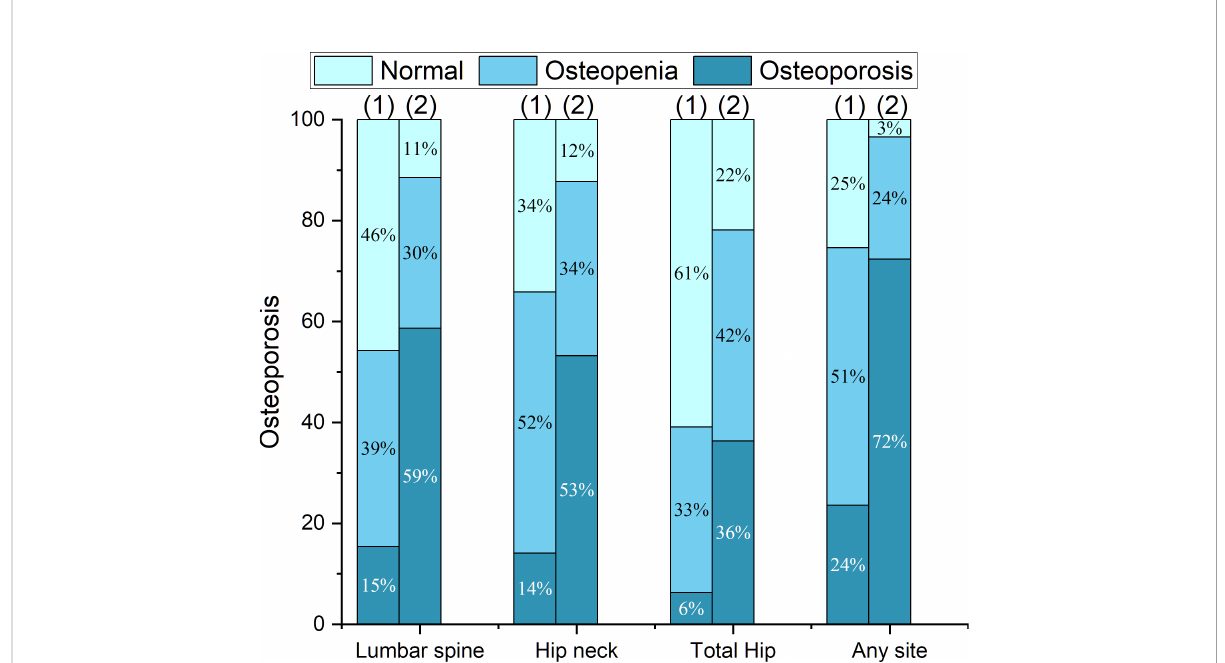
FIGURE 2 Proportions of BMD T-scores at different sites in the fracture and control groups, including: (1) the control group; (2) the PNOVFs